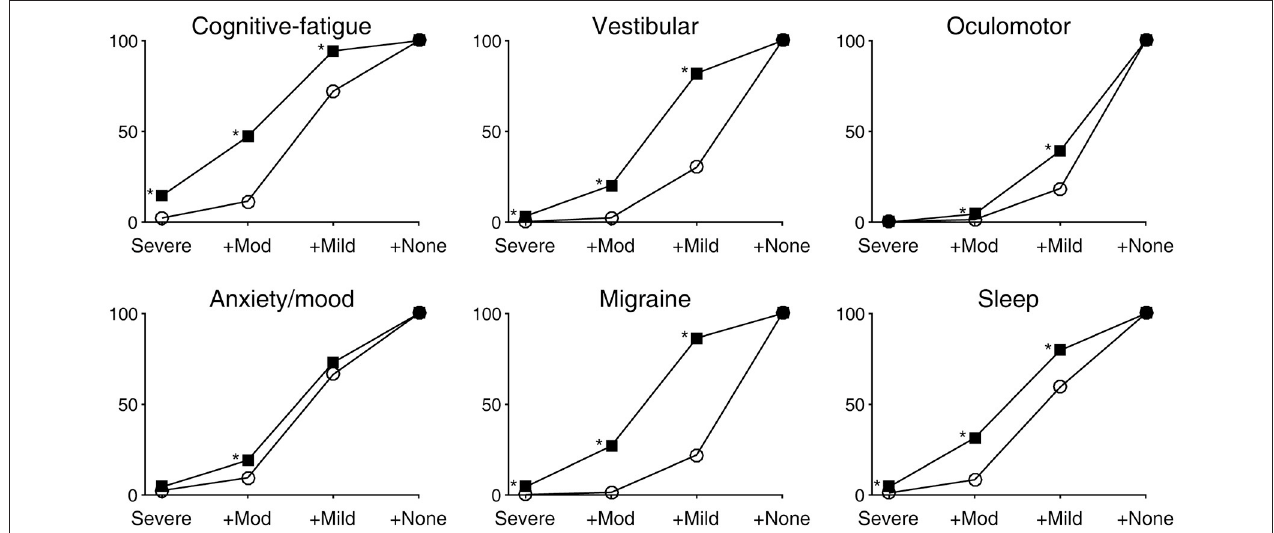
FIGURE 1 | Prevalences of six classes of symptoms expressed as cumulative distributions. Open circles and filled squares indicate baseline and post-concussion findings, respectively. An asterisk indicates a statistically significant ( p < 0.05) deviation of a post-concussion prevalence from the baseline-derived probability as determined by a binomial test. Also see Table 1 .